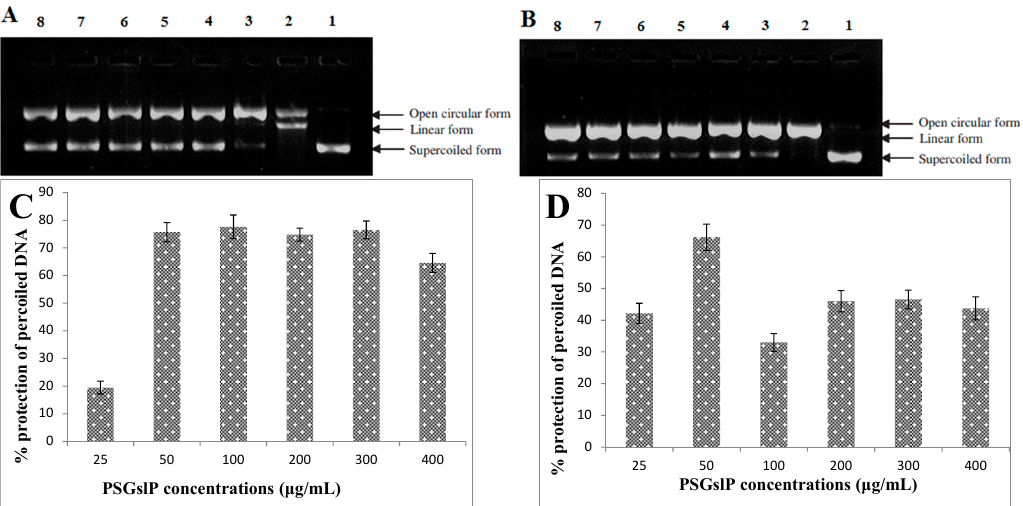
Figure 2. DNA damage-protective activity of the PSGslP. ( A ) Protective activity of the PSGslP against ROO• radical-induced DNA damage. Lane 1, the native DNA; lane 2, DNA treated with AAPH; and lanes 3–7, DNA treated with varying concentrations of the PSGslP (25, 50, 100, 200, 300, and 400 ( μ g/mL), respectively) in the presence of AAPH; ( B ) Protective activity against •OH radical-induced DNA damage. Lane 1, the native DNA; lane 2, DNA treated with 1 mM FeSO 4 and 1 mM H 2 O 2 ; and lanes 3–8, DNA treated with varying concentrations of the PSGslP (25, 50, 100, 200, 300, and 400 μ g/mL, respectively) in the presence of 1 mM FeSO 4 and 1 mM H 2 O 2 ; ( C ) Densitometric quantification of the protective activity against ROO• radical-induced DNA damage; ( D ) Densitometric quantification of the protective activity of the PSGslP against •OH radical-induced DNA damage.